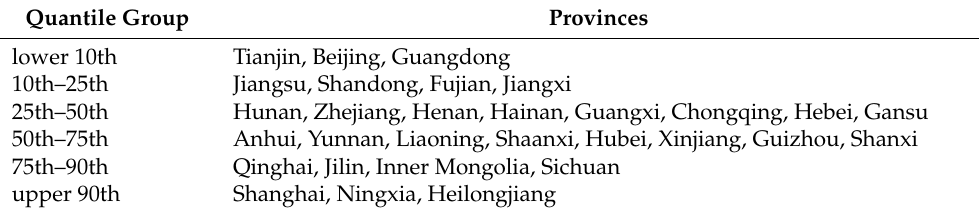
Table 6. Grouped results of 30 provinces according to the level of carbon intensity.